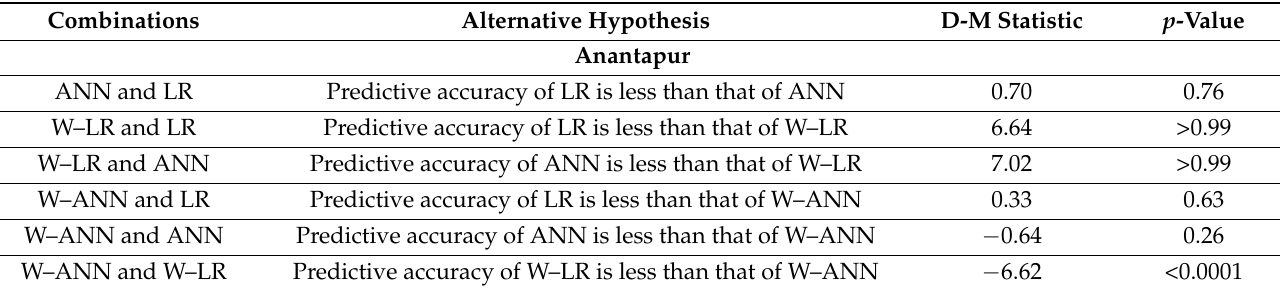
Table 9. Testing predictive accuracy by D–M